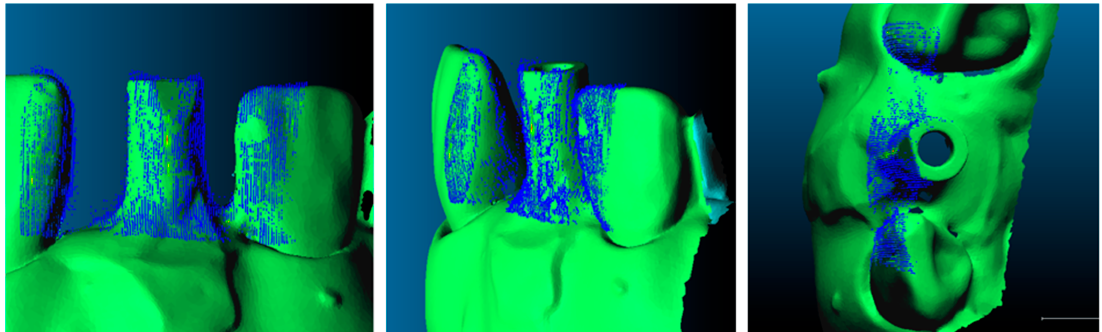
Figure 4. Test and reference datasets were aligned using manual and automatic methods to determine the closest common points. Manual alignment was performed by determining equivalent data points between data.